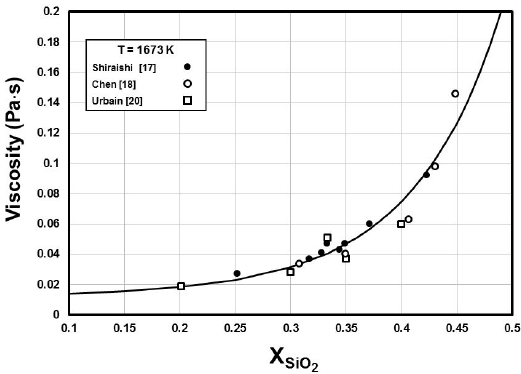
Figure 3. Calculated (line) and experimental (points) viscosities at 1673 K of SiO −FeO melts. 2 Table 3. Experimental and calculated viscosities of the SiO X NO° Shiraishi et al. 17 Myslevic et al. 14 Kucharski et al. 19 Urbain et al. 20 SiO2